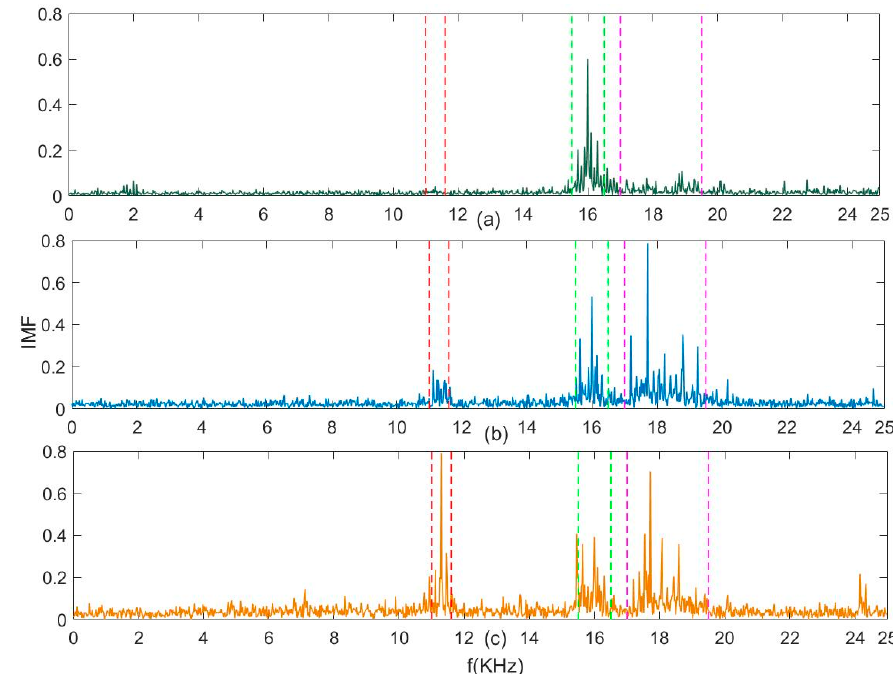
Figure 5. The first IMF frequency spectrum of vibration signals at the different stage. ( a ) The first IMF frequency spectrum of vibration signals at the initial stage; ( b ) The first IMF frequency spectrum of vibration signals at the middle stage; ( c ) The first IMF frequency spectrum of vibration signals at the late stage.